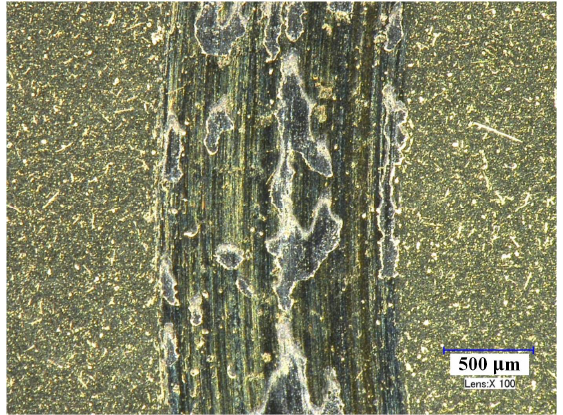
Figure 7. The SZT coating breaking off at the wear track (speed 60 m/min, load 10 N, sliding time 5 min).